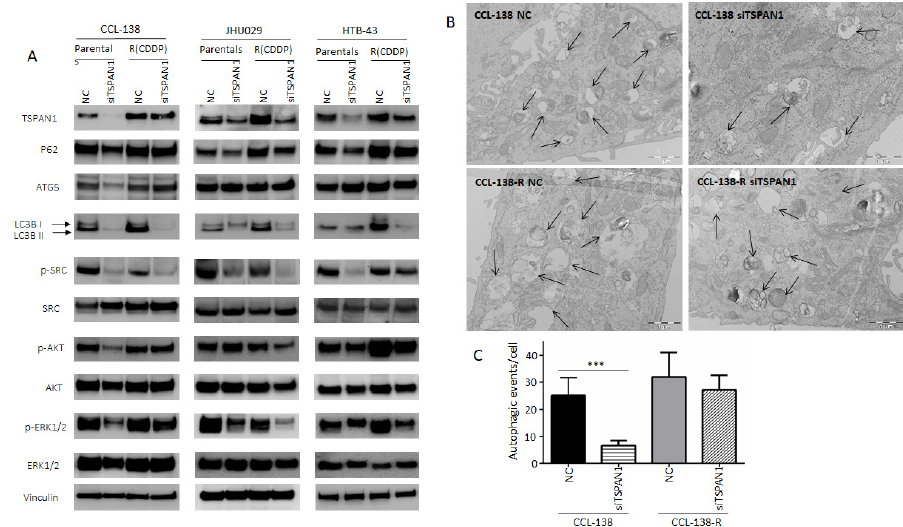
Figure 4. Characterization of TSPAN1 downstream effectors. ( A ) Western blot analysis of proteins SRC / AKT / ERK signaling pathways. ( B ) Representative electronic microscopy images in TSPAN1-depleted cells vs. control cells (NC) in CCL-138 and CCL-138-R cells. TEM images revealed autophagosomes